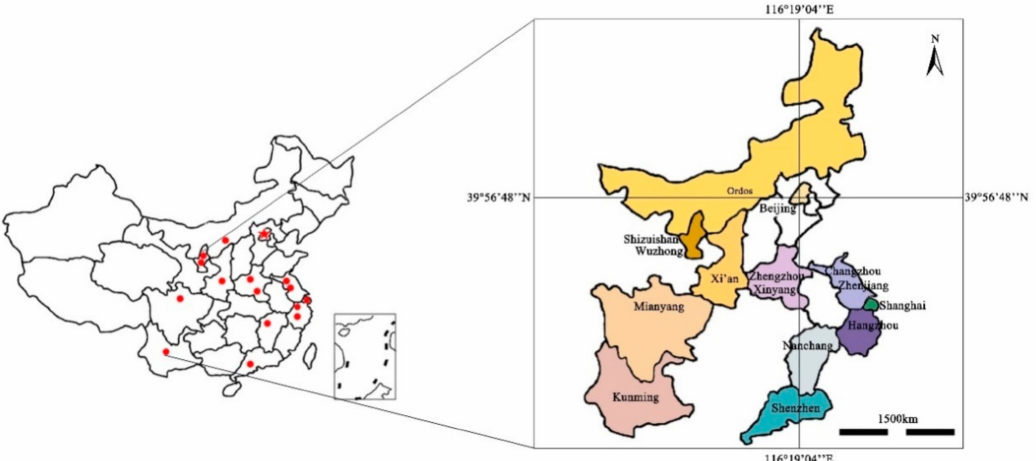
Figure 1. Geographical location of 16 urban lakes sampled in